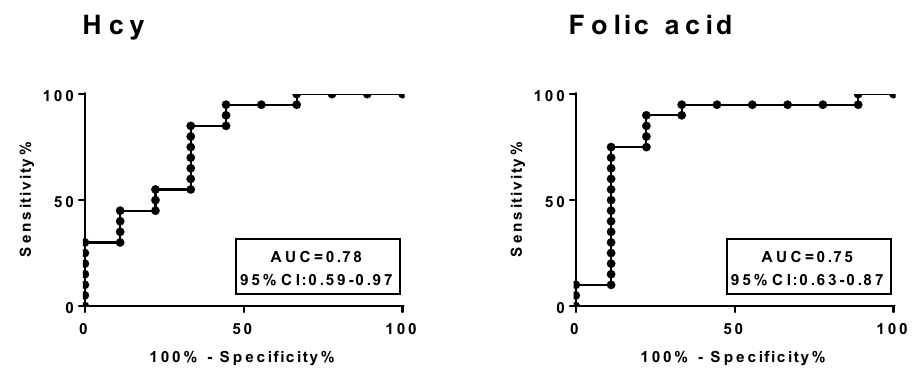
Figure 3: Receiver operating characteristic curve (ROC) curve of prediction value of yolk sac visualization serum Hcy and folate levels for the outcome of threatened